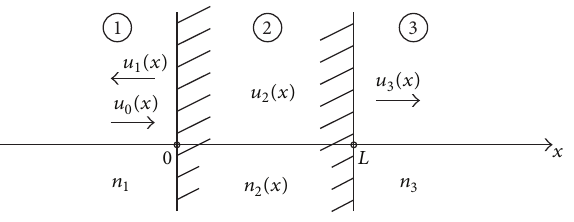
Figure 1: Geometry of the